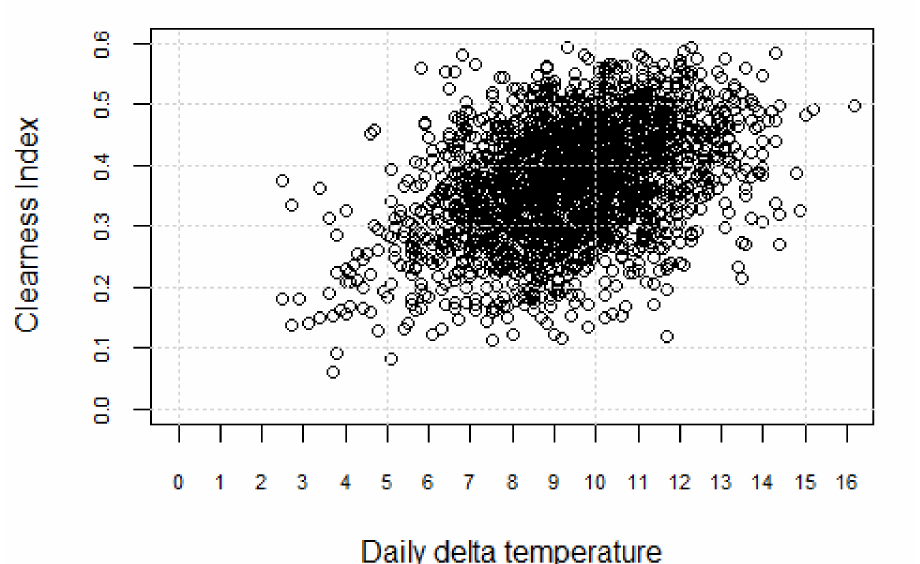
Figure 4. Daily delta of temperature–clearness index for Viento Libre.